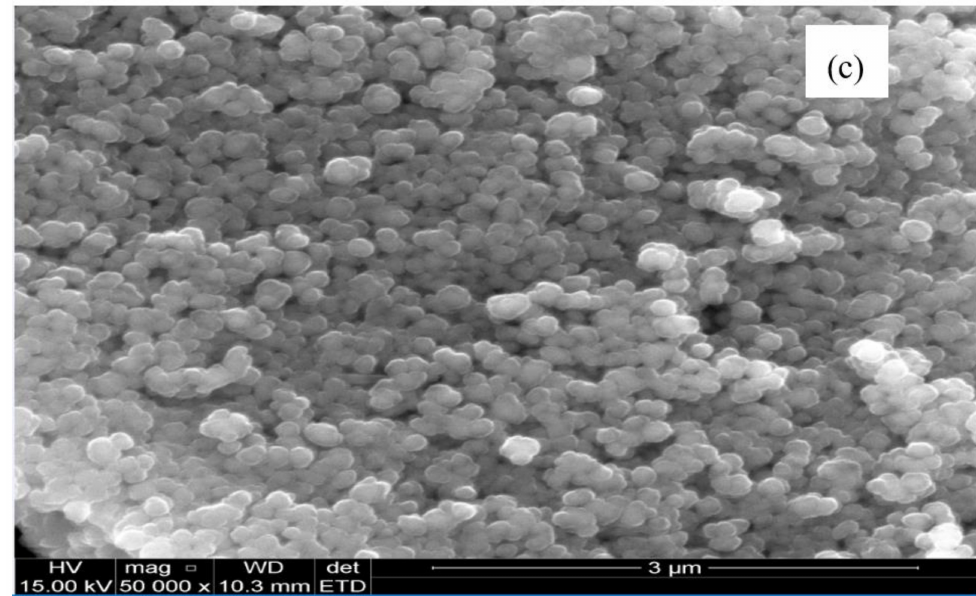
Figure 6. The SEM images of ( a ) GPE / ZnO NPs, ( b ) LPE / ZnO NPs and ( c ) OPE / ZnO NPs.